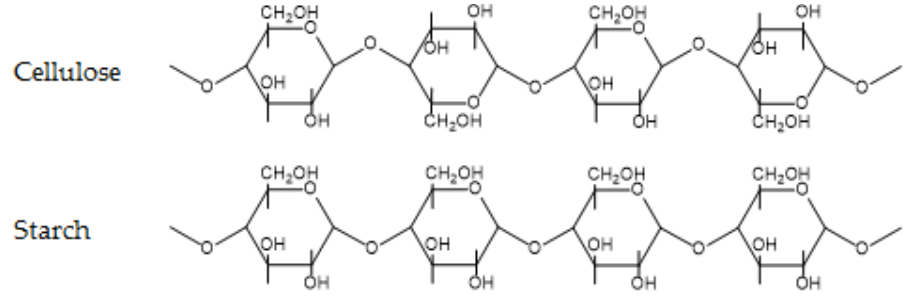
Figure 4. Chemical structure of cellulose and starch.